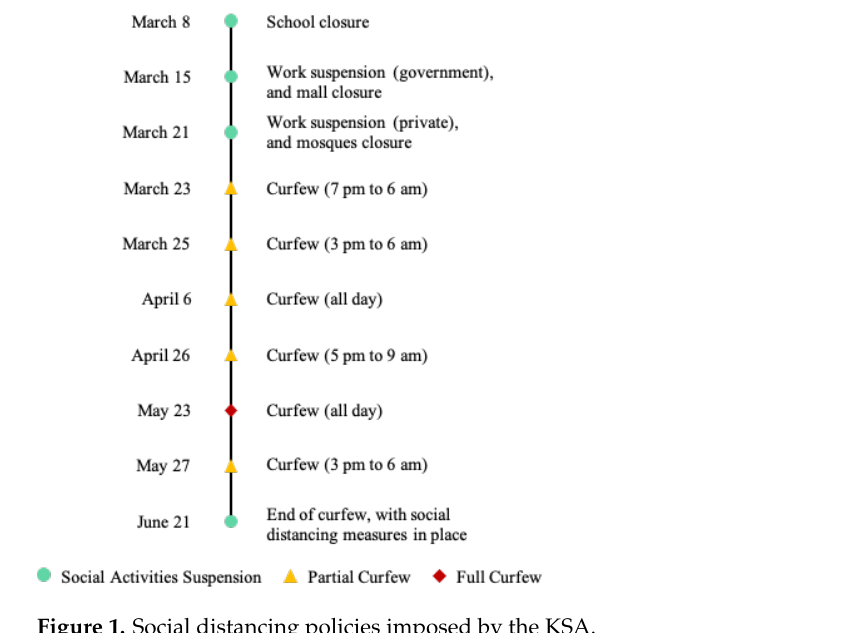
Figure 1. Social distancing policies imposed by the KSA.